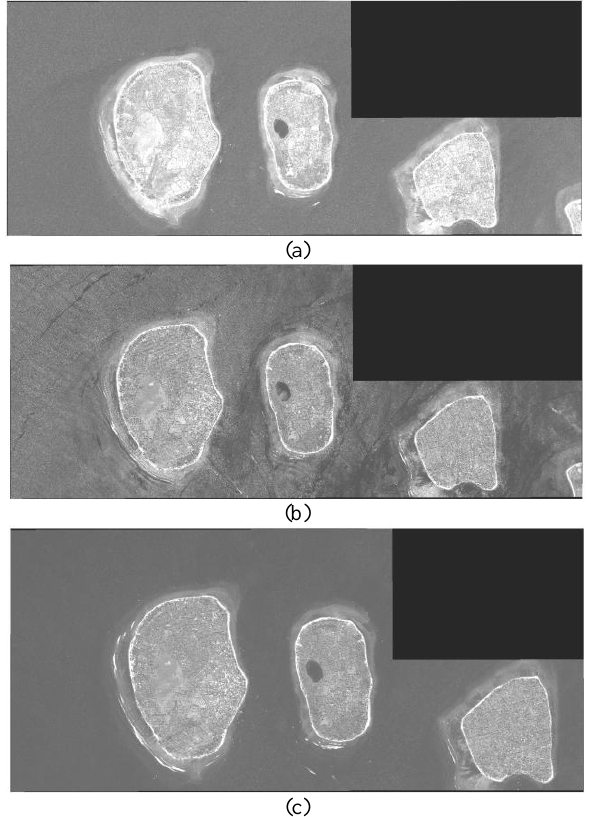
Figure 4. Satellite image with accusition time October 2013 (a), May 2014 (b), and June 2014 (c) Satellite imagery have 2 channels namely multispectral with 3 bands and panchromatic with one band. Multispectral Channel has a spatial resolution of 2m, while the panchromatic channel has a spatial resolution of 0.5m. The channels used for making a DEM in this study is panchromatic channel. Panchromatic channel selected because this channel have the best spatial